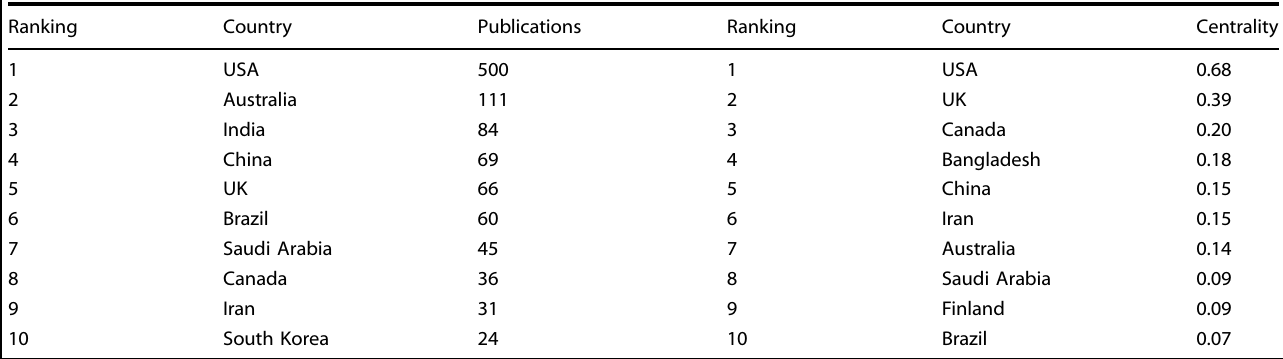
Table 1. Top 10 countries according to the number of publications and centrality. Ranking